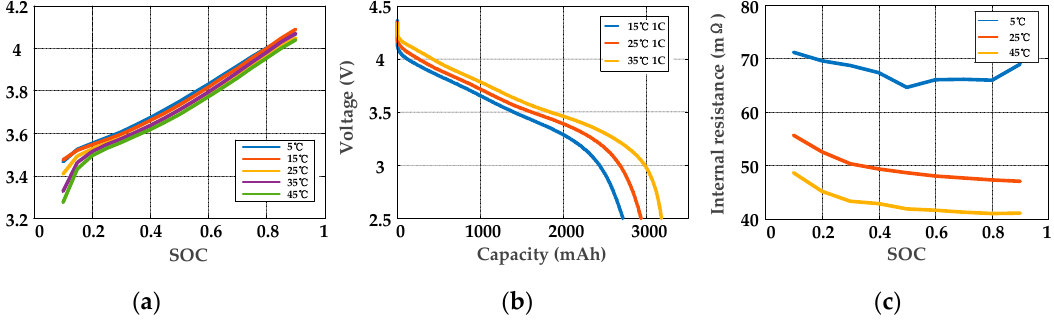
Figure 1. Battery characteristics under different ambient temperature conditions. ( a ) Relationship between state of charge (SOC) and open circuit voltage (OCV), ( b ) battery maximum discharge capacity, and ( c ) relationship between SOC and internal resistance.